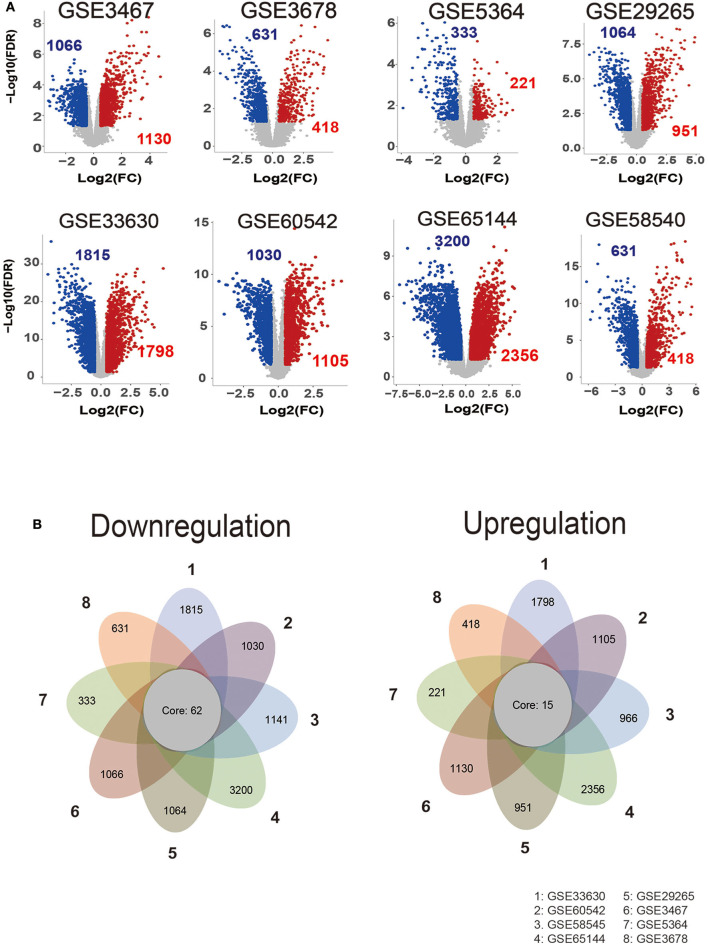
Identification of commonly dysregulated genes in different datasets. (A) Volcano plot of DEGs in selected gene expression datasets. (B) Flower plot of eight GEO profiles in downregulation and upregulation.